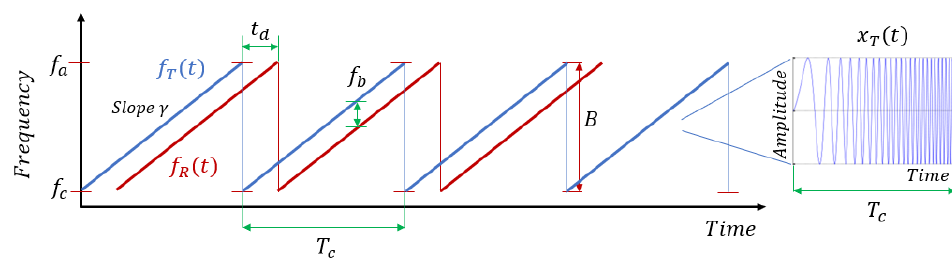
Figure 3. FMCW sawtooth wavefor: plot of the transmit (blue) and receive (red) frequency signal over time. x T ( t ) indicates the transmit amplitude signal vs time for a chirp interval T c